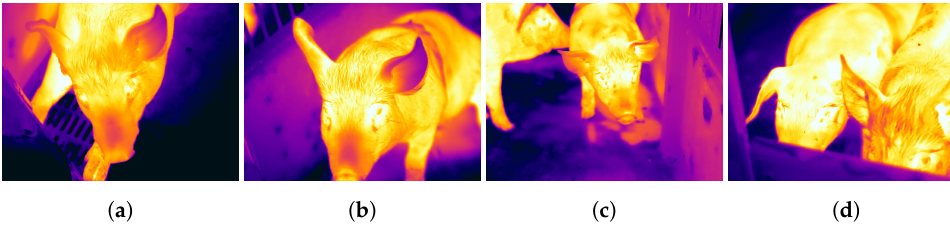
Figure 7. Thermal images of different pig treatments [53]. ( a ) IAF, ( b ) IBF, ( c ) PAF, and ( d )